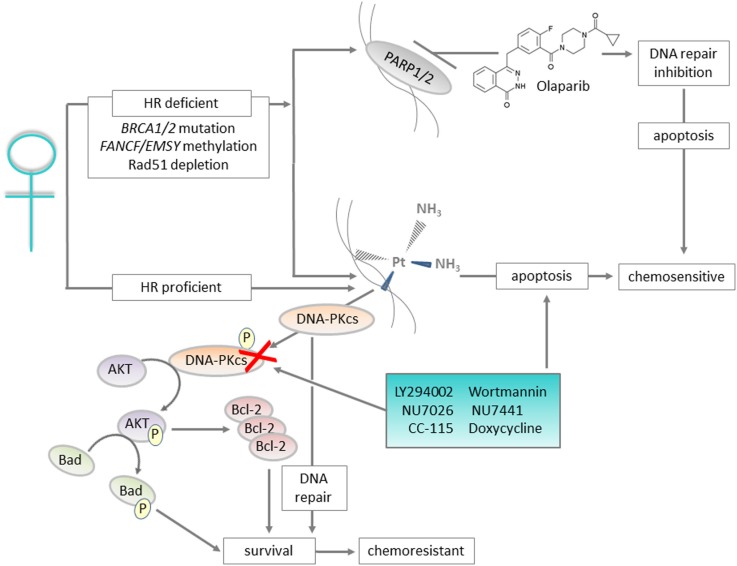
Graphical summary: DNA repair proteins such as DNA-PKcs can be targeted to improve outcomes for patients with ovarian cancer. Ovarian cancers with defects in the homologous recombination (HR) pathway are initially sensitive to platinum treatment, and also respond to Olaparib that targets the base excision repair pathway protein PARP. For the majority of cases, which are HR proficient, platinum-based chemotherapy is still utilized but resistance is likely. For patients with platinum-resistant disease, inhibition of DNA-PKcs, a key component of the non-homologous end joining pathway, represents a targeted approach to prevent the pro-survival AKT and anti-apoptotic signaling associated with resistance.